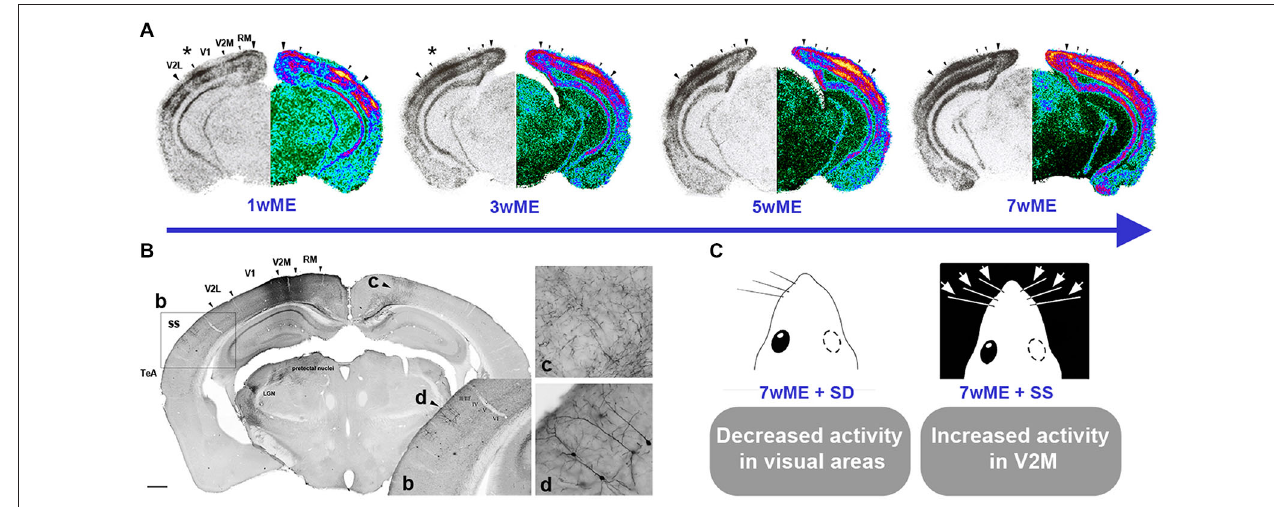
and retrograde transport of fluororuby upon injection in V2M of a 7wME mouse. b: Detail of Fluororuby signal at the location of somatosensory cortex: tracer is transported in an anterograde way to axon terminals in layers V and VI, while supragranular layers II/III contain retrogradely labeled cell bodies and dendrites. c: Detail of anterogradely labeled fibers in contralateral V2M. d: Detail of retrogradely labeled pyramidal cells in layers II and III of ipsilateral/adjacent somatosensory cortex. (C) Subsequent whisker manipulations in 7wME mice were employed in order to verify the functional relevance of the intermodal connections in the ME-induced reactivation profile. Somatosensory deprivation (SD) by trimming the right-side vibrissae results in decreased visual cortex activity whereas somatosensory stimulation (SS) through exposure to toys and novel objects in the dark increased activity, especially in V2M. Adapted from Van Brussel et al.